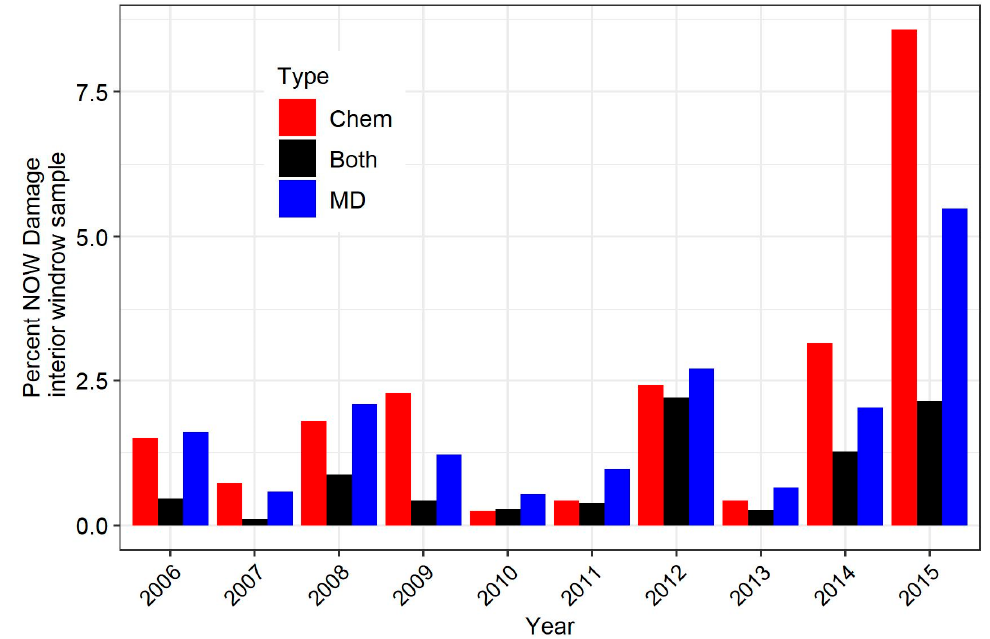
Figure 2. Mean navel orangeworm damage for all almond varieties for 2006 to 2015, as determined from interior windrow samples. The insecticide (Chem) indicates plots that received insecticide but not mating disruption; the mating disruption (MD) treatment category includes all mating disruption treatments when used without insecticides, and the Both treatment category includes all mating disruption treatments when used with insecticide. Table 3. Percent navel orangeworm damage (mean ± SE) from interior windrow samples, by insec- ticide and mating disruption treatment and across all varieties, 2006–2015.